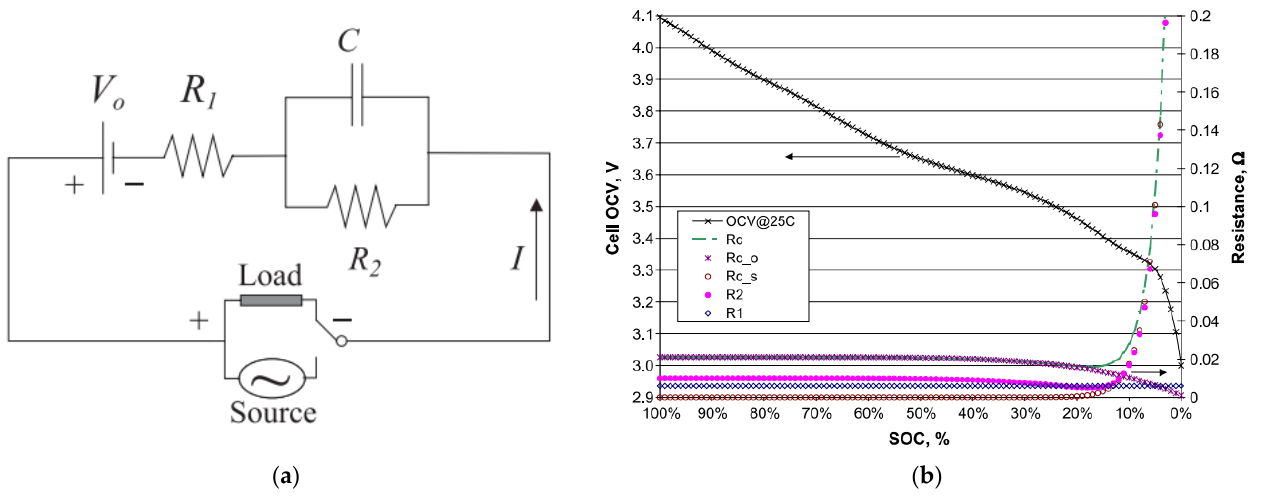
Figure 10. ( a ) The equivalent circuit model of Liaw et al. [40 – 42] , to simulate LiB performance for Gen 2 cells ( b ) The SOC-dependent OCV and resistance values for the total cell resistance ( R c and the two independent contributions R co and R cs ), R 1 , and R 2 of the Gen 2 chemistry in the model. Adapted with permission from [40]. Copyright 2014